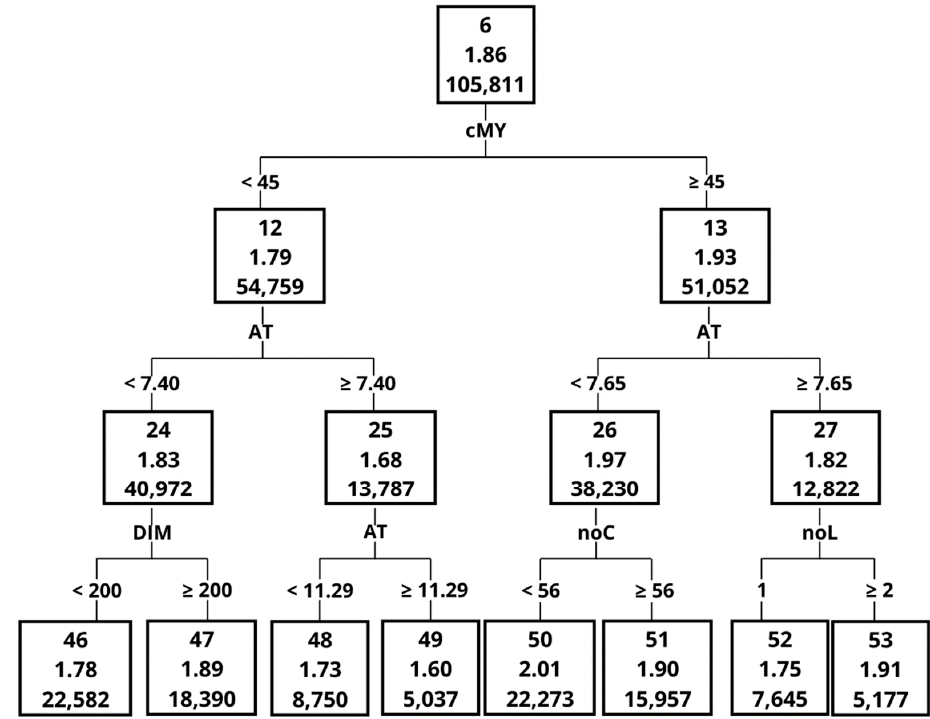
Figure 5. The graphical model of the decision tree—part 4.